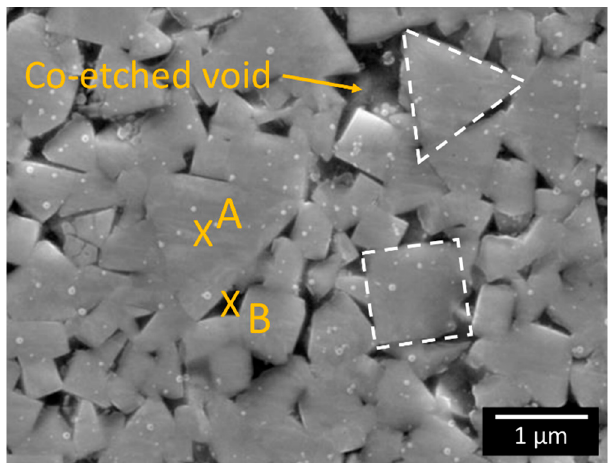
Figure 1. FESEM cross-sectional view of the base WC-Co microstructure after chemomechanical polishing. The dashed outlines show the triangular and rectangular grains. The white dots are residual SiO 2 particles (60 nm size) left by the chemomechanical polishing. The arrow points to a Co-etched void that appeared after chemomechanical polishing.